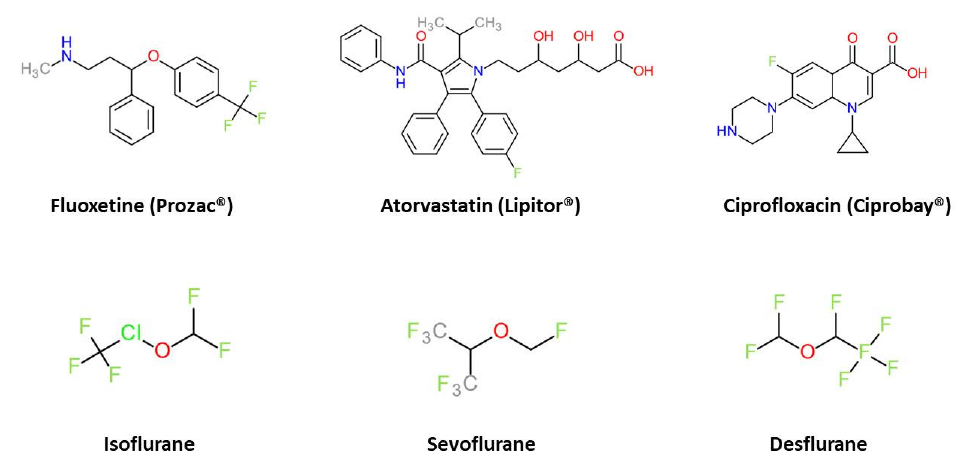
Figure 2. Important fluorinated compounds in